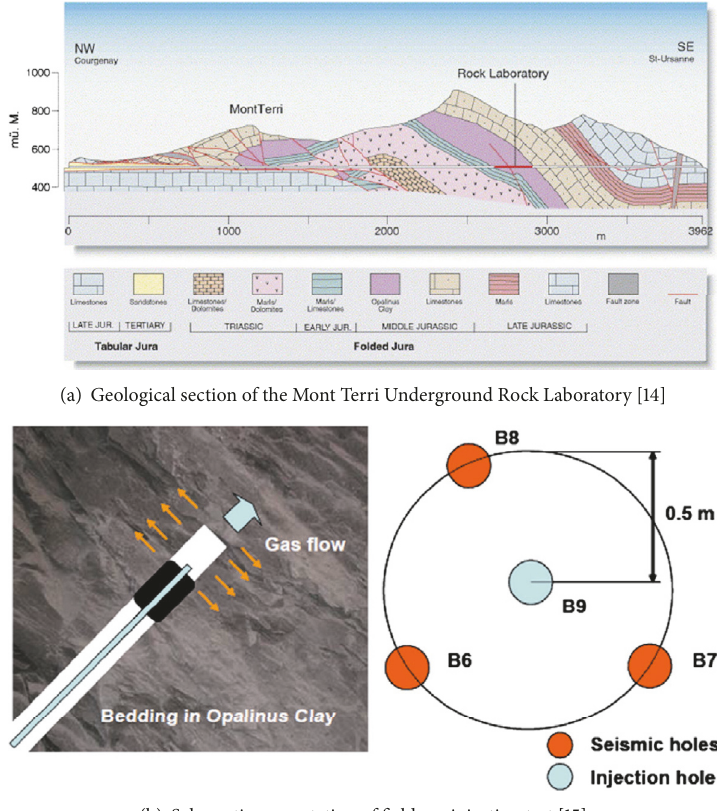
Figure 3: Location of rock laboratory and field gas injection test.